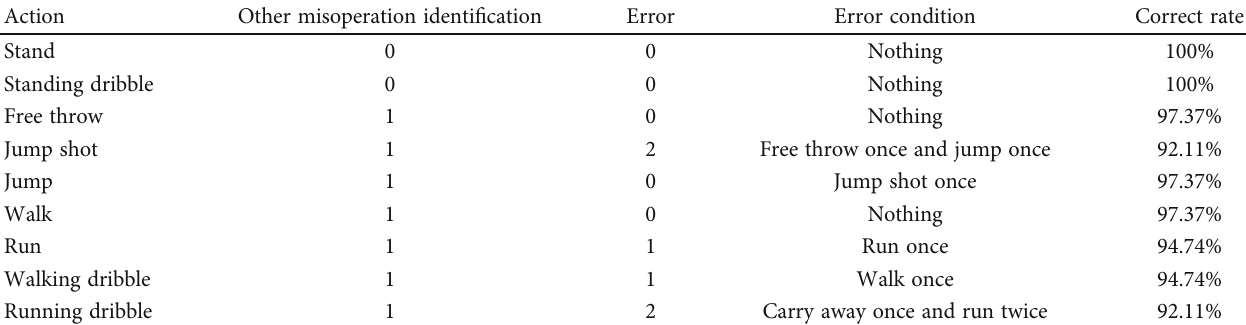
Table 8: Recognition accuracy of di ff erent side placement methods of object set identi fi ed by decision tree.